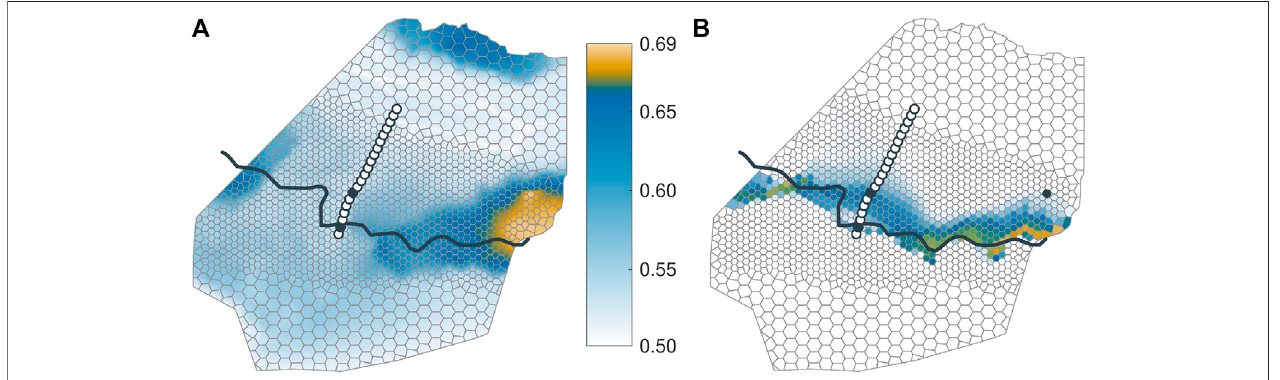
FIGURE 9 | Assessment of measurement designs with the third piezometer being placed outside the transect. (A) Performance ϕ of the design as a function of where the third observation well is placed; (B) map of the misclassi fi cation probability P mc for the optimal three-piezometer design with one additional piezometer not being restricted to the transect (same colormap as in Figure 7